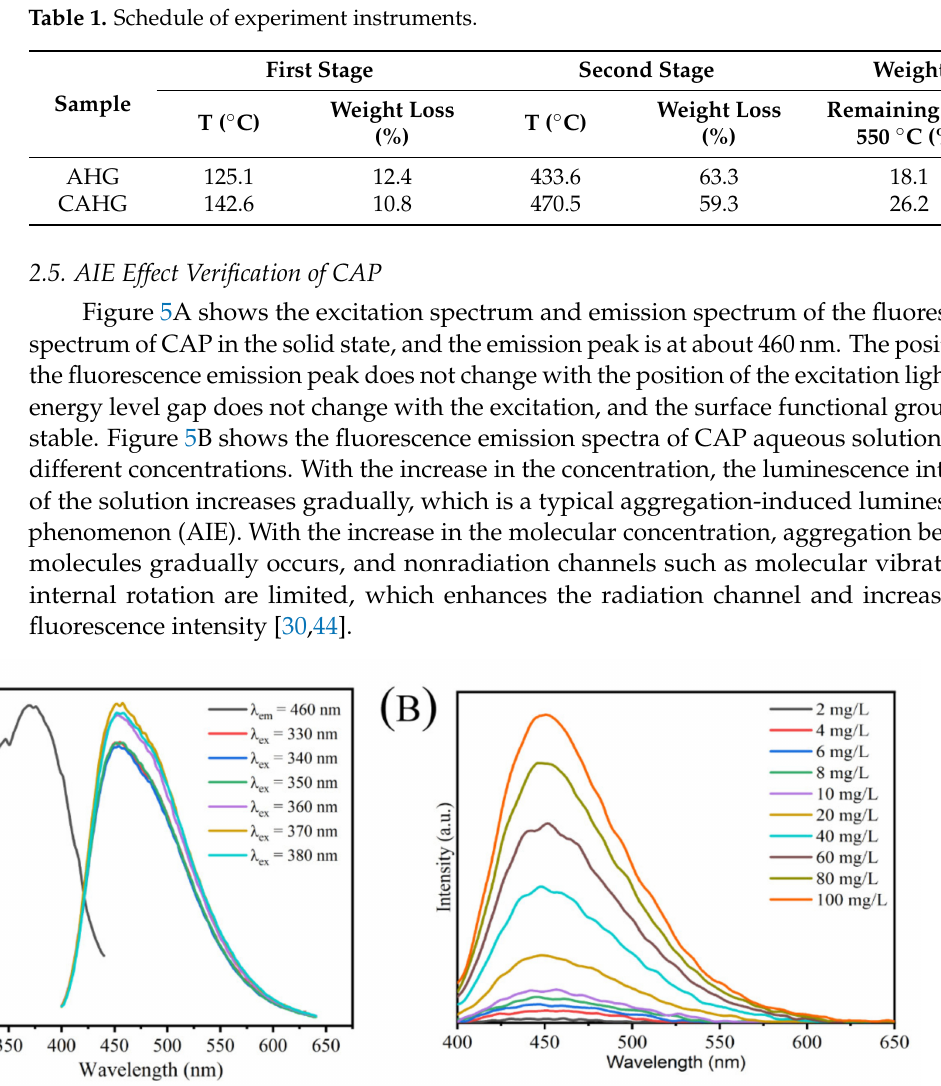
Figure 5. Fluorescence emission and excitation spectra of CAP ( A ); fluorescence emission spectra of CAP in water with different concentrations ( B